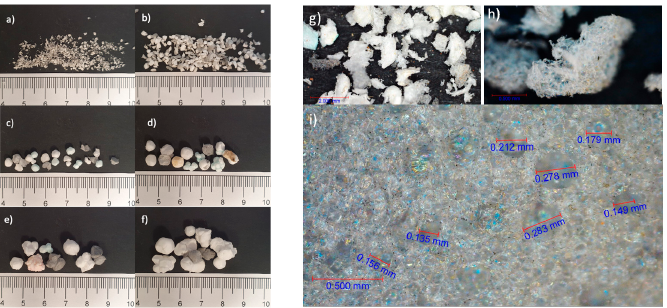
Figure 5. Appearance and macrostructure of different particle size EPS granules: ( a ) <1 mm;